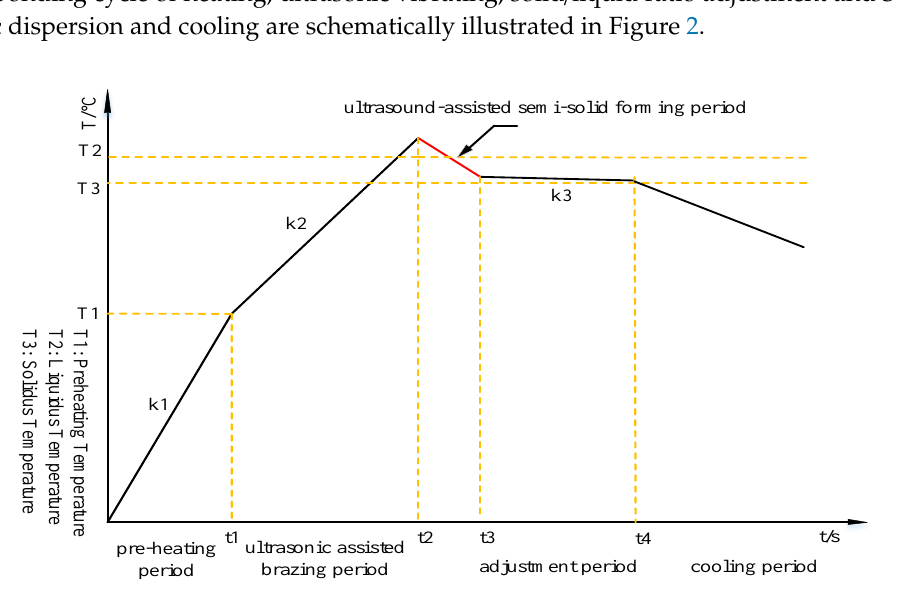
Figure 1. Schematic representation of bonding process for vibration brazing.